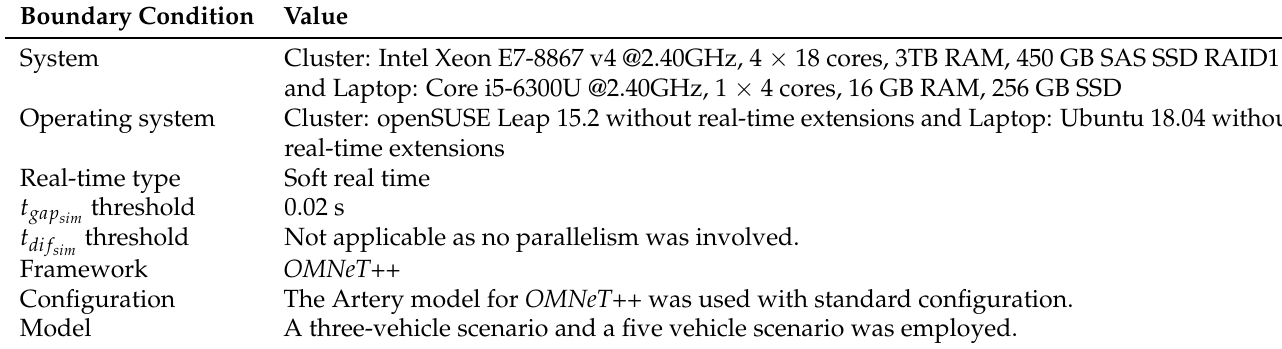
Figure 10. Real-time capabilities of a five vehicle scenario on two different setups. Taken from [40]. Table 3. Boundary conditions for the real-world example taken from [7].